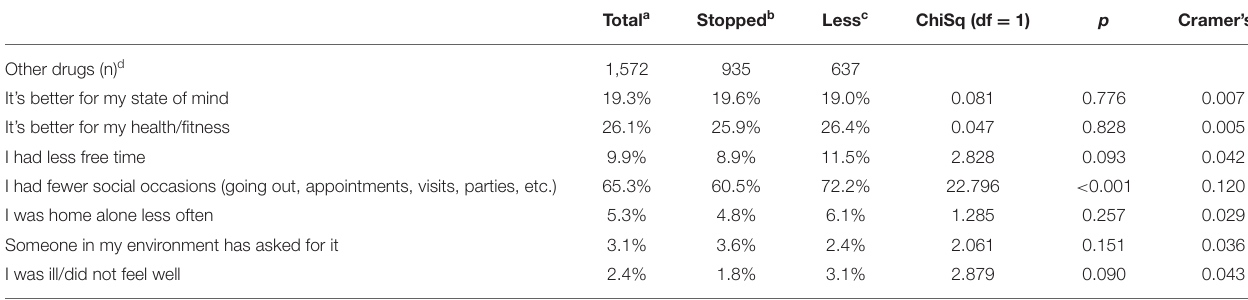
TABLE 5 | Reasons for discontinued/decreased other drug